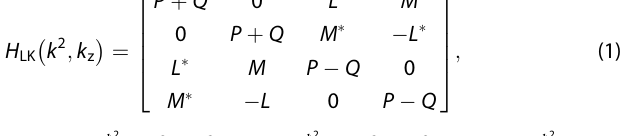
ffiffiffiffiffiffiffiffiffiffiffiffiffiffiffiffiffiffiffiffiffiffi p ω 2 þ ω 2 = 4 , ω c = eB / m p is the cyclotron frequency. The 0 c